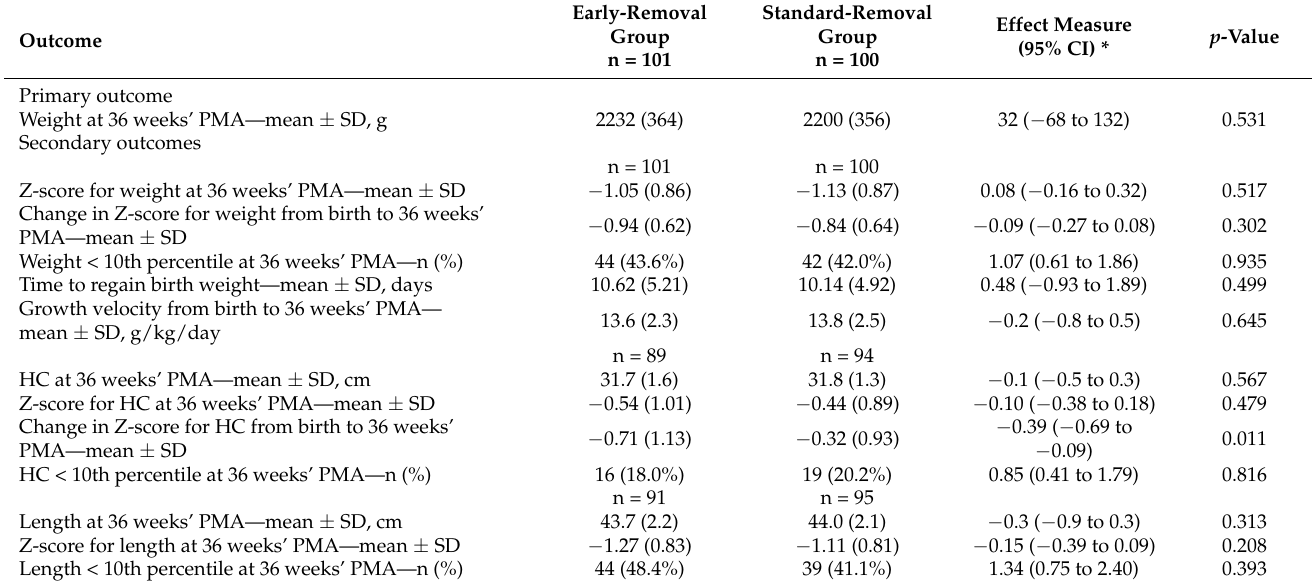
Table 2. Primary and secondary growth outcomes.